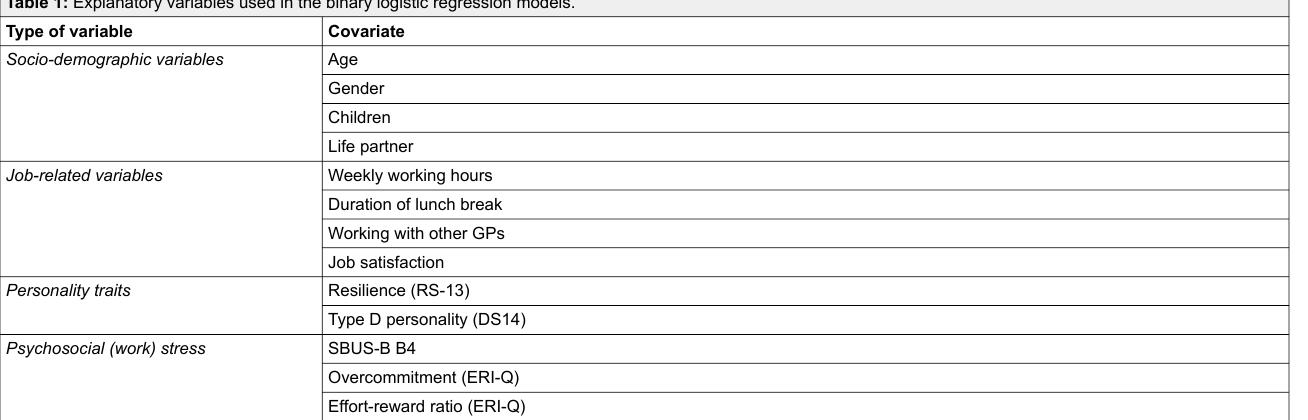
Table 1: Explanatory variables used in the binary logistic regression models. Type of